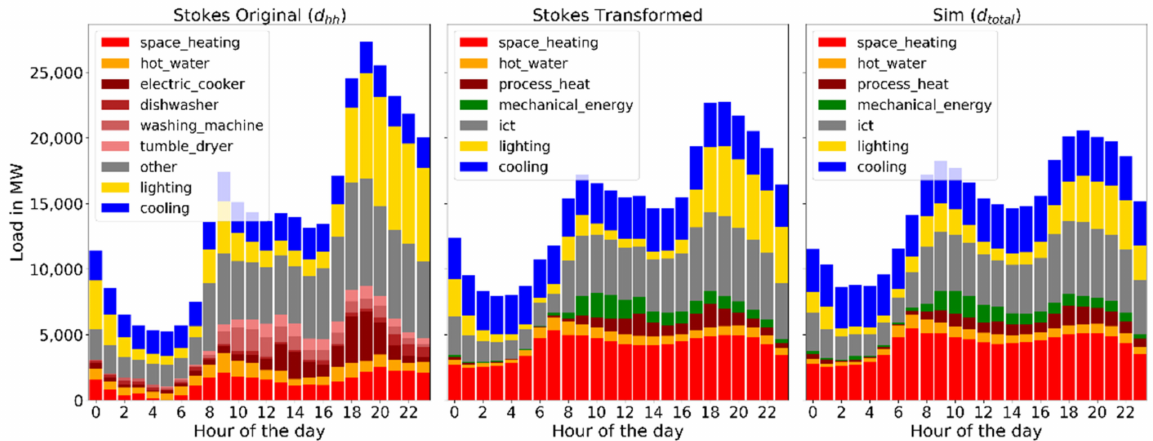
Figure A6. Stokes’ original load curve (left) vs. transformation to AGEB end-uses (middle) vs. our simulation results using NNs (right) for the average winter weekday (December–February) in the United Kingdom. The first step from Stokes original to Stokes transformed replaces the load curves of space heating and hot water by the SLPG, merges the electric cooker and the wet appliances into process heat and mechanical energy, and rescales each end-use with its respective Eurostat consumption. The step from Stokes transformed to our simulation uses the trained neural networks and has comparably small